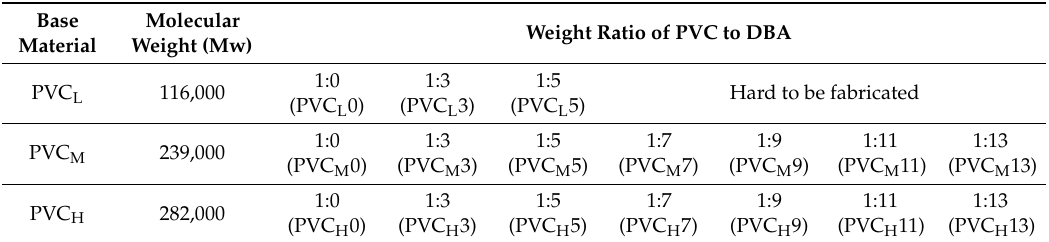
Table 1. Prepared PVC gels with DBA (dibutyl adipate) plasticizer and PVC of various molecular weights. Base